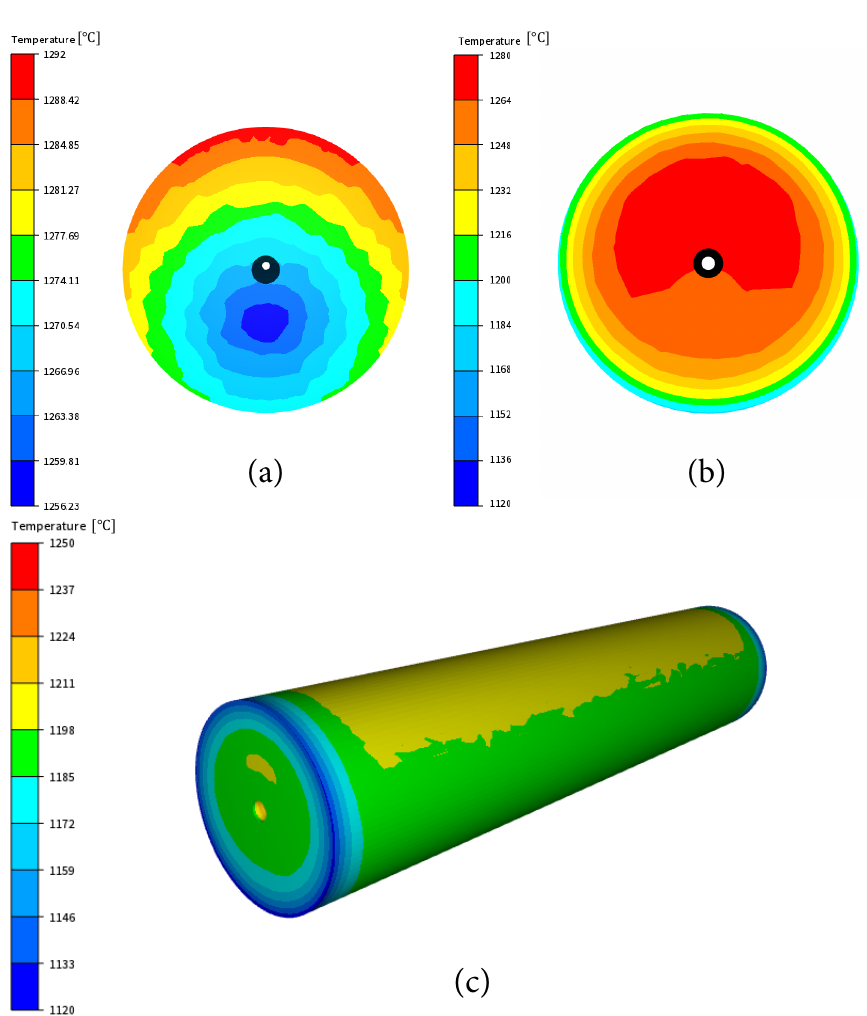
Figure 7. Temperature of the billet: ( a ) cross-section before, ( b ) cross-section after the cooling period and ( c ) longitudinal distribution after the cooling